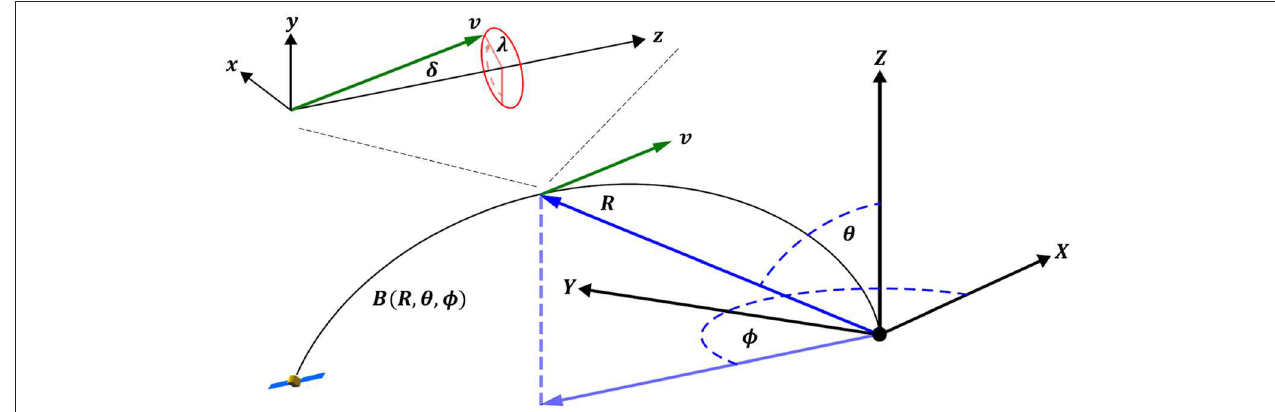
, {ˆ R , ˆ θ , ˆ φ and beam } }